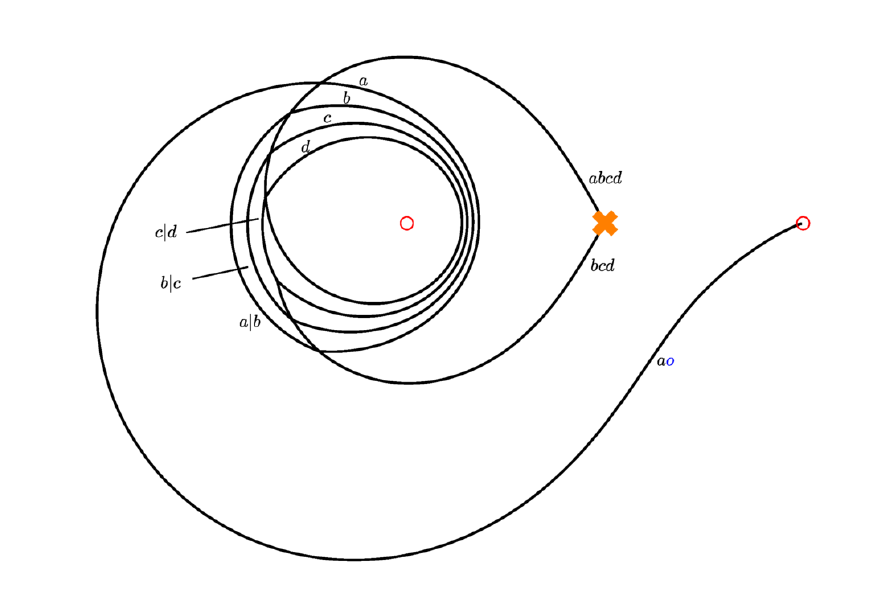
Figure 58. D4 + 4D0, corresponding to the partitions (4) and (1,1,1,1).